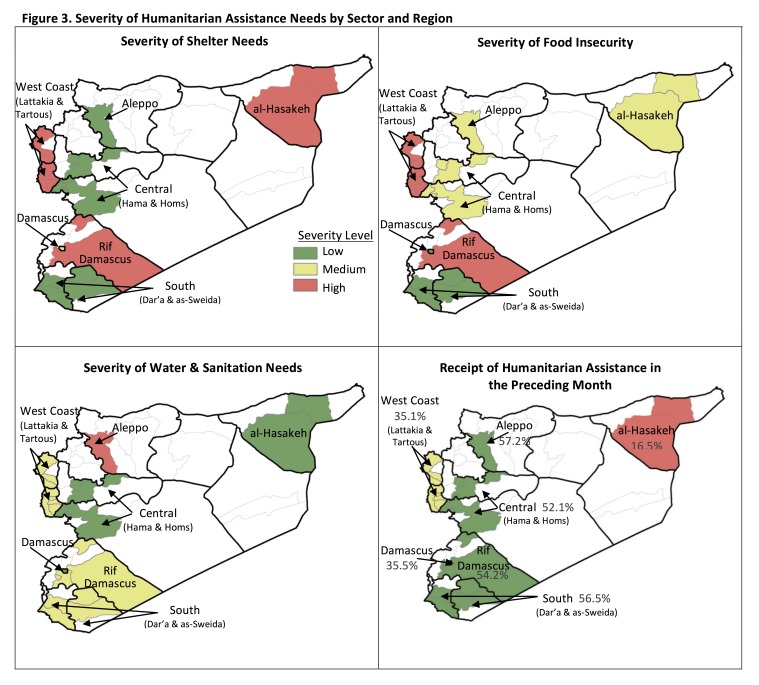
Figure 3. Severity of Humanitarian Assistance Needs by Sector and Region